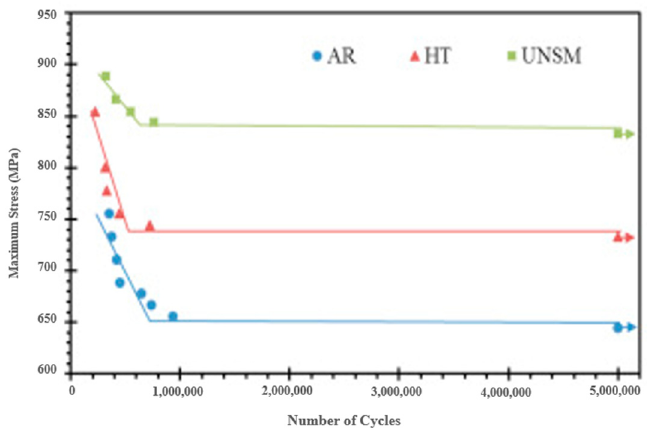
Figure 11. SN curves of AR, HT, and UNSM’ed substrate. Reprinted with permission from ref. [69]. Copyright 2018, Elsevier.